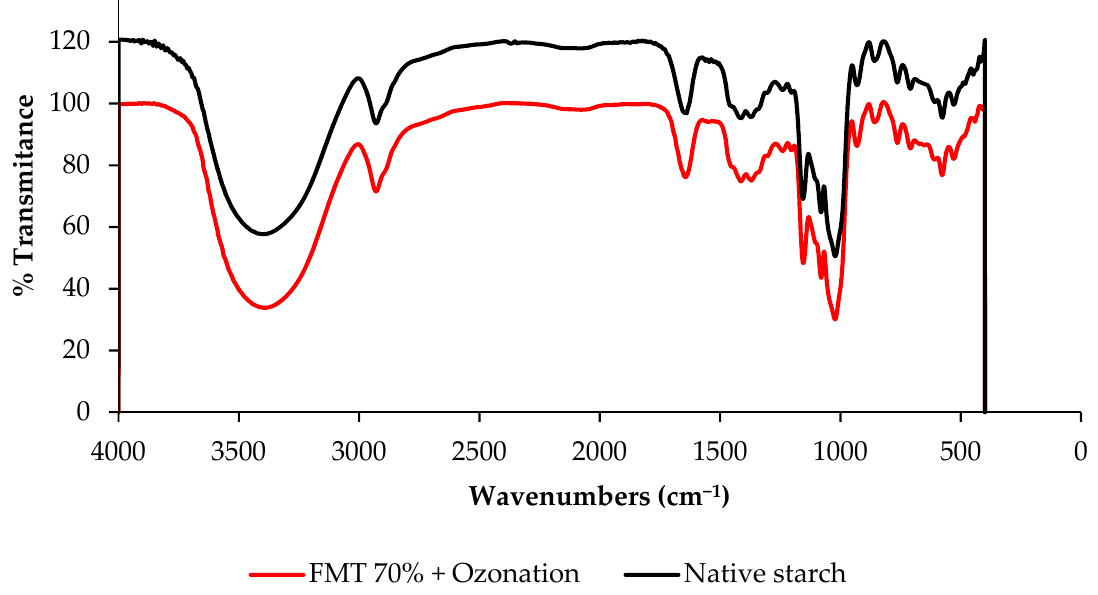
Figure 7. The FTIR-ATR spectra of native adlay starch and adlay starch modified by FMT 70% + ozonation. Table 3. FTIR-ATR spectra band assignment for adlay starch.